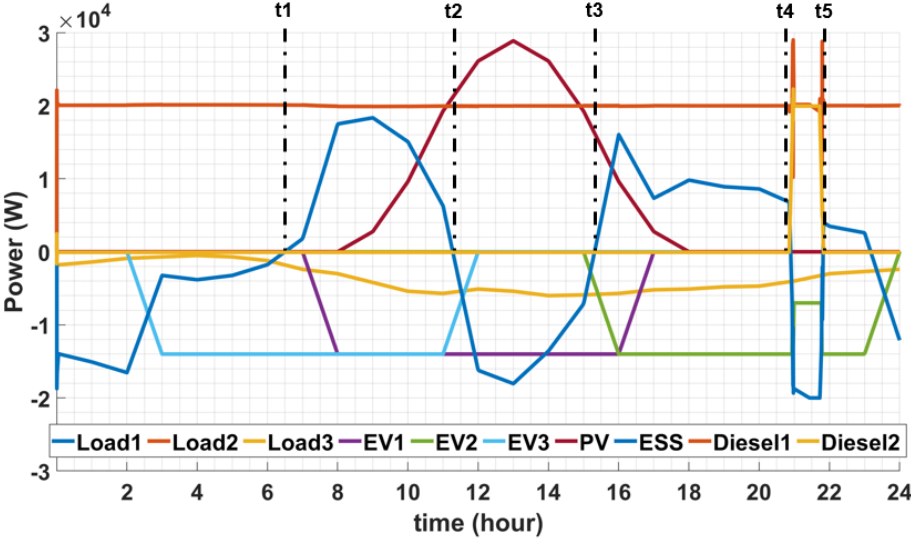
Figure 11. Active power of the stand-alone MG.